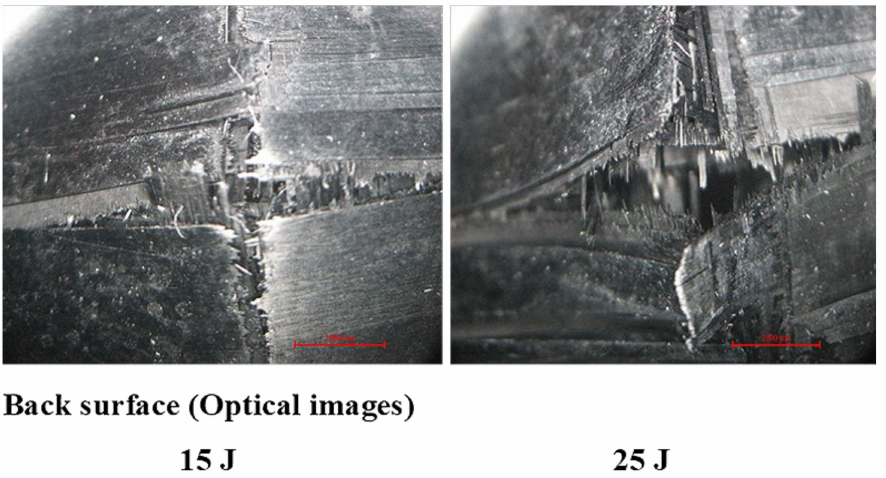
Figure 19. Pictures of the back surface failure view with visual and optical microscopy of [B/B] at 15 and 25 J.